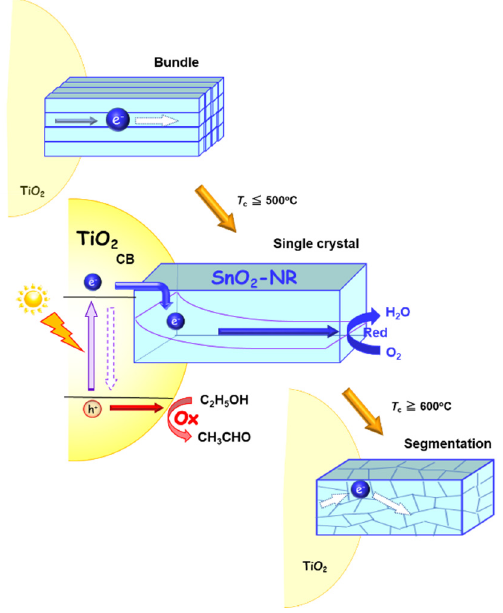
Scheme 3. Heating effect of the SnO 2 -NR#TiO 2 photocatalyzed on the oxidation of ethanol to aldehyde.